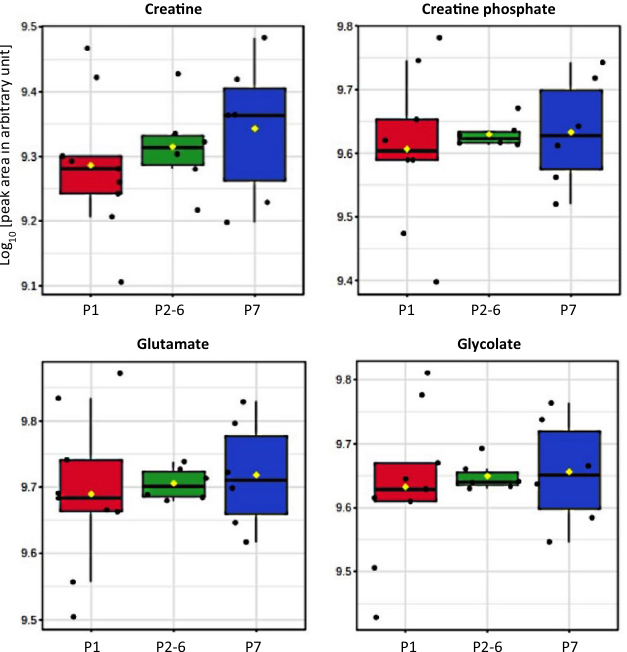
Figure 5. Box-whisker plots of comparative quantification of indicative non-volatile polar metabolites (log10 [peak area in arbitrary unit]) responsible for discrimination among colostrum samples (day 0) collected from sows in in parity 1 (red), parity 2–6 (green) and parity 7 (blue). The lower and upper edge of the box denote 25th and 75th percentile of observation, respectively; the bold line within box denotes median value; the rhombus spot within box ( (cid:31) ) denotes average value; whiskers denote 5th and 95th percentiles. For interpretation of the significant difference among mean values of samples, the reader is referred to the MIXED model statistical tests in Table